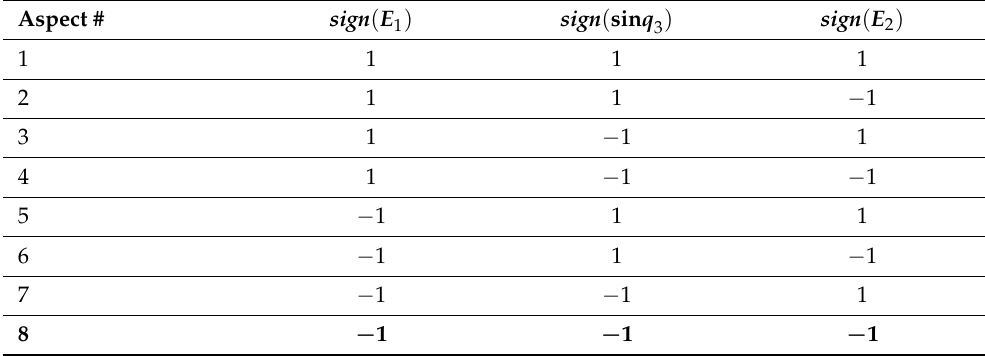
Table 1. Rules for determining the aspects for the UR-5